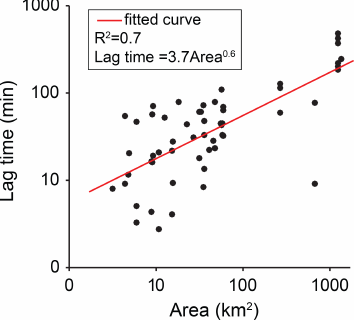
Figure 7. Modeled lag time vs. basin area for all flash floods with peak discharge > 5m 3 s − 1